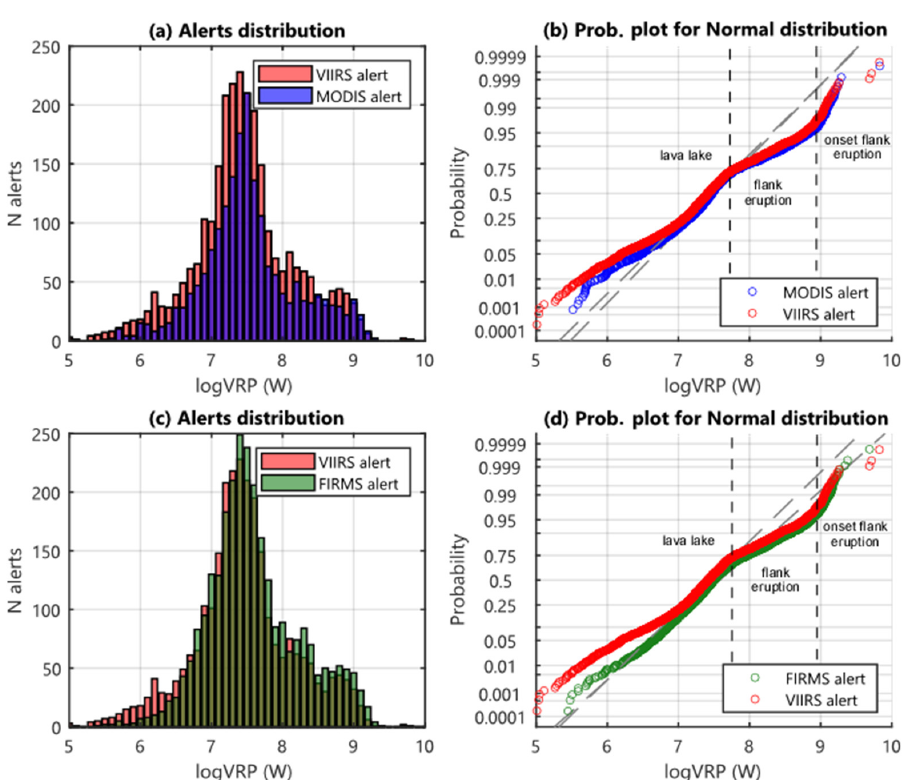
Figure 8. Histograms ( a , c ) and probability plot ( b , d ) for Erta Ale datasets. ( a , c ) Histograms display data distribution related to VRP in logarithmic scale (0.1 MW–1 GW), with a range between the classes of 0.1; blue bars represent the distribution of MODIS data, the red ones represent MIROVA VIIRS data, and green bars represent FIRMS VIIRS data. ( b , d ) Probability plots for normal distribution of MIROVA VIIRS (red), MIROVA MODIS (blue), FIRMS VIIRS (green) datasets; the dashed grey lines represent the reference lines of the theoretical distributions. The main changes of the slope are identified with black dashed lines and correspond to the different regimes of activity that characterize Erta Ale’s last decade.